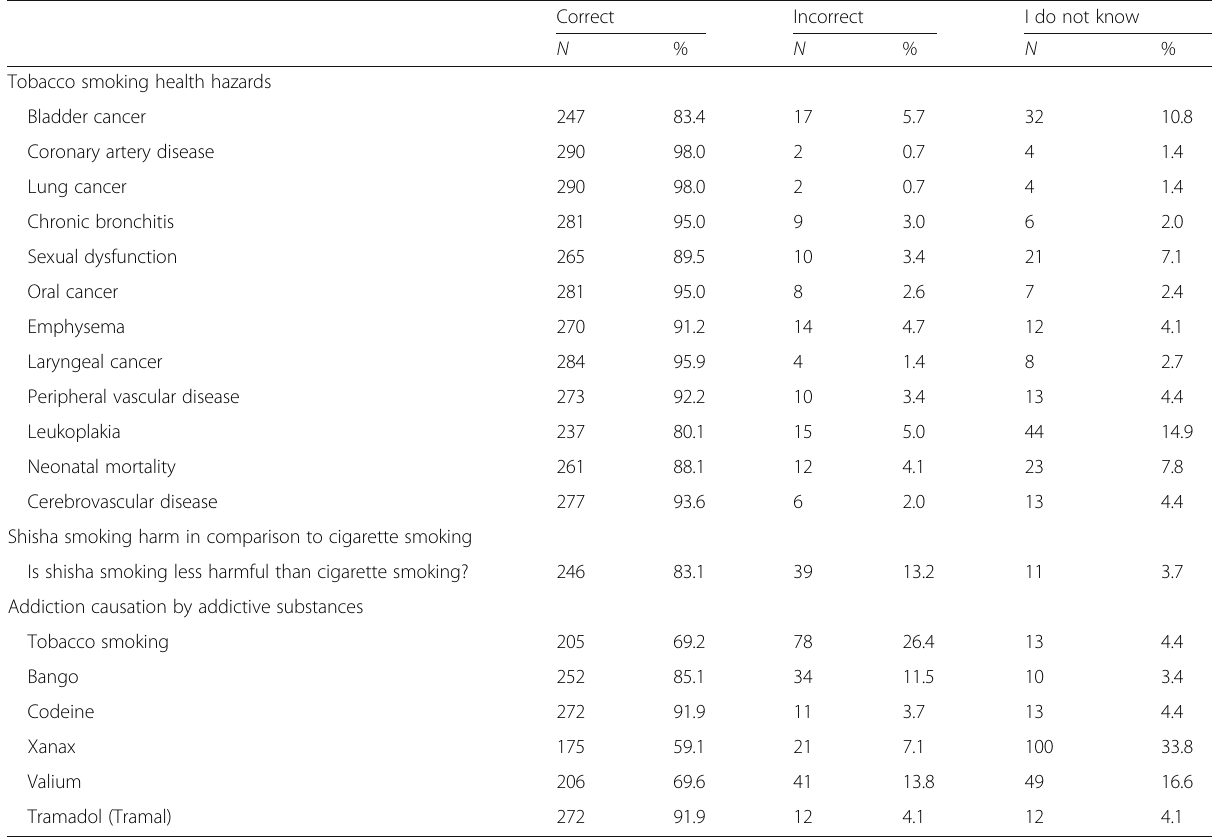
Table 1 Knowledge of students regarding health hazards of tobacco smoking and addictive effect of different substances, Cairo University, academic year 2014 –